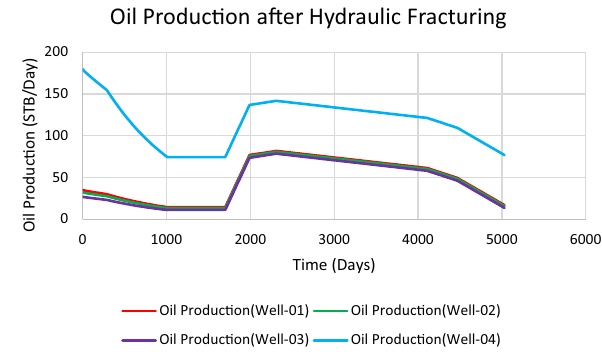
Fig. 10 Oil production after hydraulic fracturing